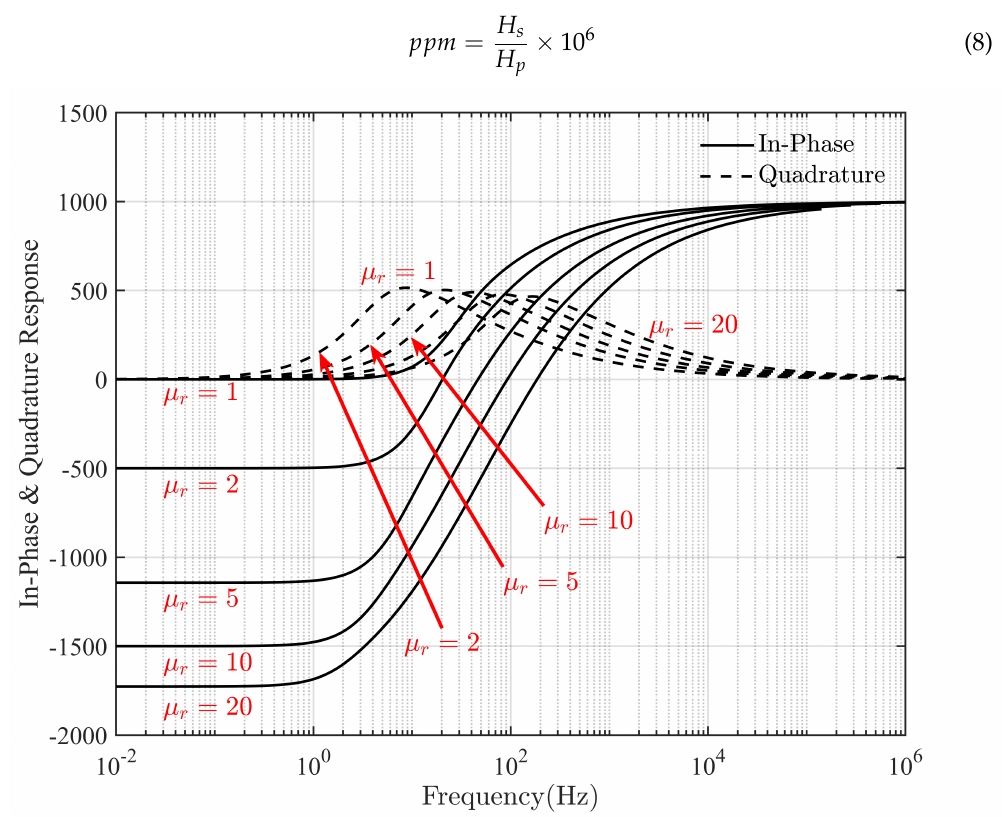
Figure 2. In-phase (solid curves) and quadrature (dashed curves) response components of a solid conductor